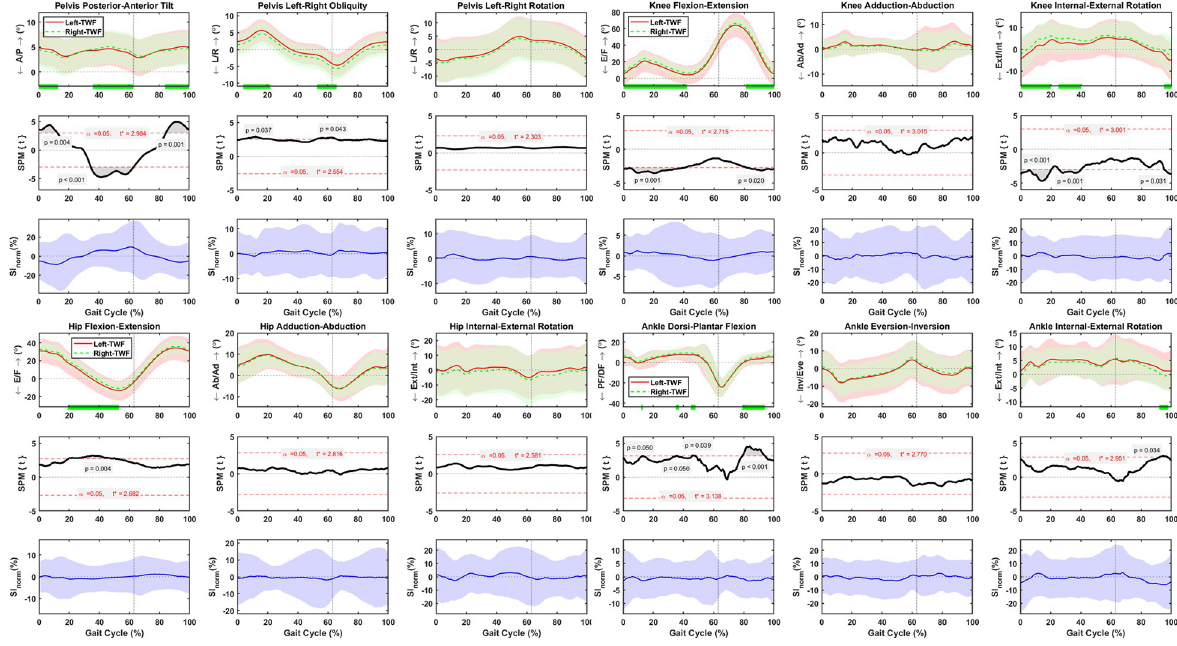
Fig 6. Average and standard deviation of pelvis posterior-anterior (P/A) tilt, left-right (L/R) obliquity, and (L/R) rotation, hip and knee flexion-extension (F/E), adduction-abduction (Ad/Ab), and internal-external (Int/Ext) rotation, and ankle dorsi-plantar flexion (DF/PF), eversion-inversion (Eve/Inv), and internal-external (Int/Ext) rotation for left and right sides during one gait cycle of normal treadmill walking (TWN) in sixty healthy participants. Green bars on the horizontal axis and the scalar field SPM results with threshold t � t depict where, in % cycle, left side angles were greater or lesser than right side angles. The normalized symmetry index (SI norm ) calculated during one gait cycle of TWN. Solid and dashed lines correspond to average left and right sides, as well as average SI norm , and shaded areas correspond to standard deviation. Black dotted vertical lines denote